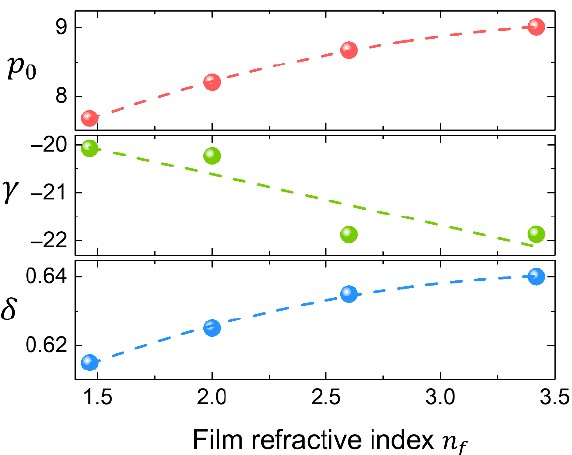
Figure 3. The parameters defining the MG depolarization factor p that best fits 𝑛̃ 0 , as a function of film index. The scaling parameters for the dashed curves are shown in Table 1. Table 1. The NLEM model parametrization.